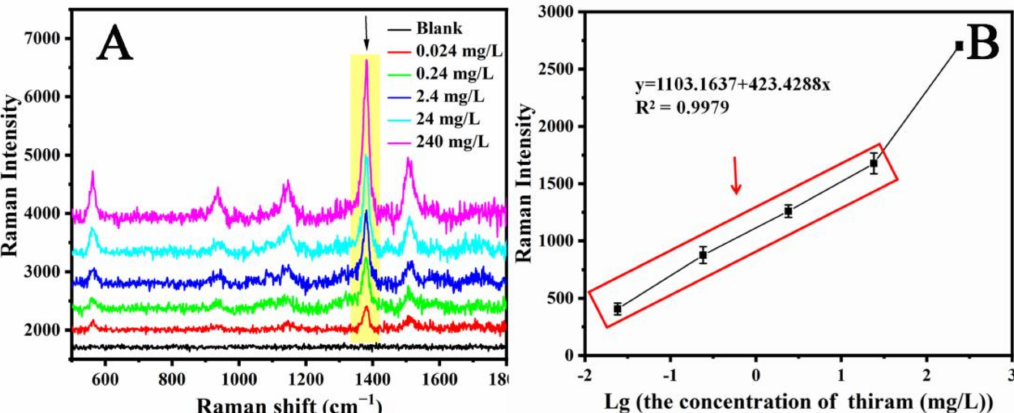
Figure 5. ( A ) Raman spectra of different concentration of thiram on MC/Ag NPs film substrates. ( B ) Raman intensity at 1384 cm − 1 as a function of thiram concentration with the SERS calibration curve for thiram. Error bars represent the standard deviations of five measurements ( n =